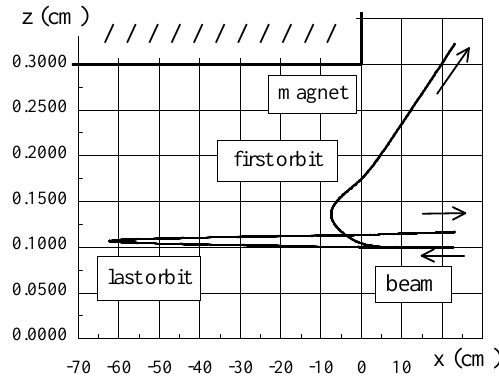
FIG. 4. Trajectories of the first and the last orbits of a particle coming into the extended fringe field 0.1 cm above the middle